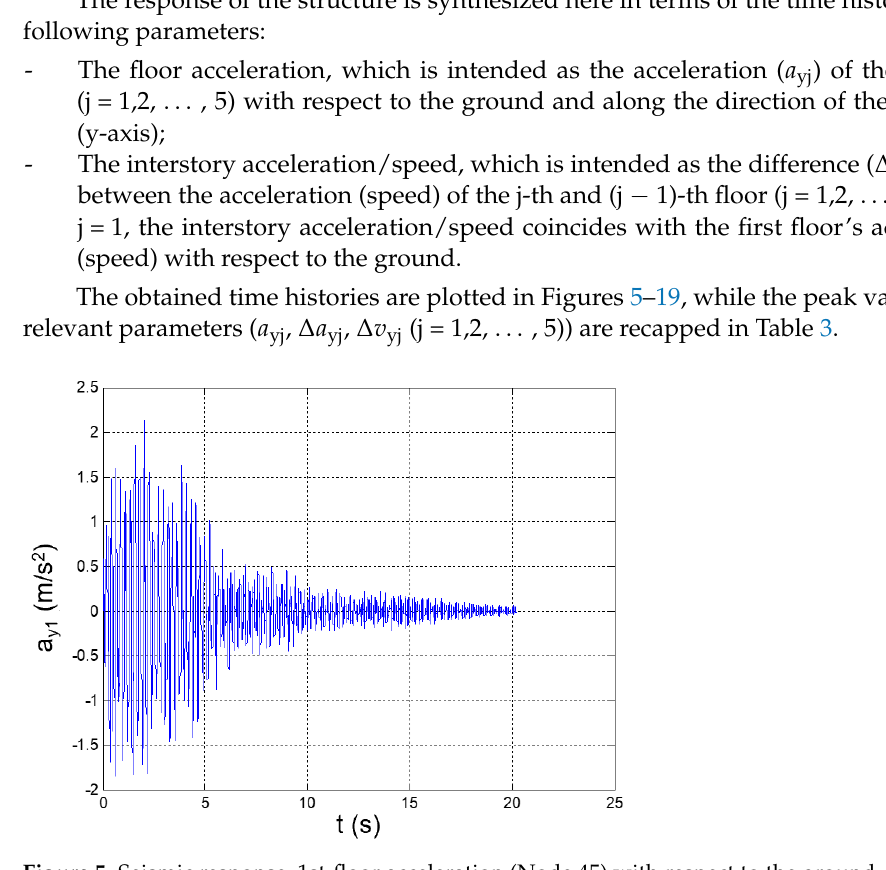
Figure 5. Seismic response, 1st-floor acceleration (Node 45) with respect to the ground.